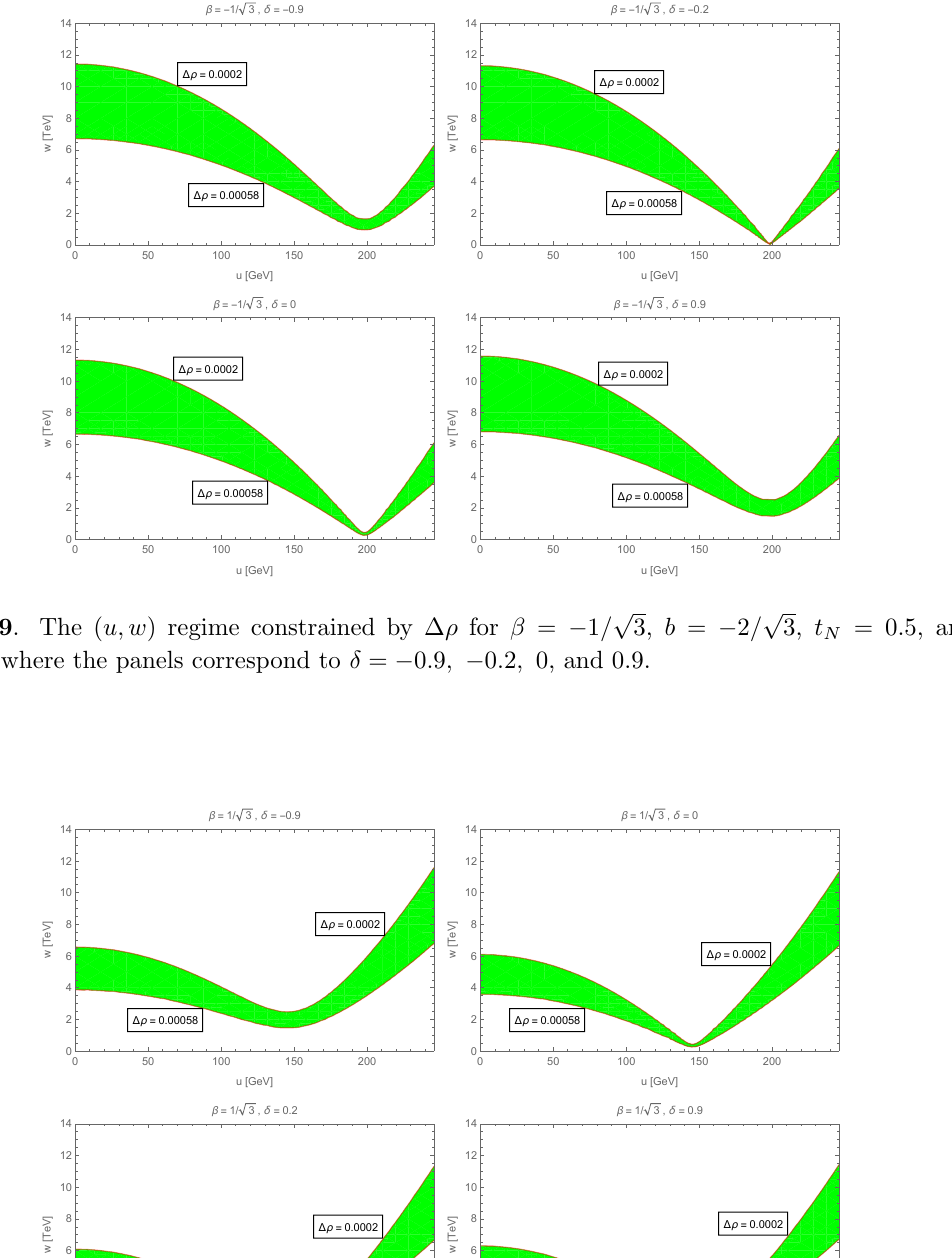
2 / √ 3, t = 0 . 5, and Λ = 2 w , N −